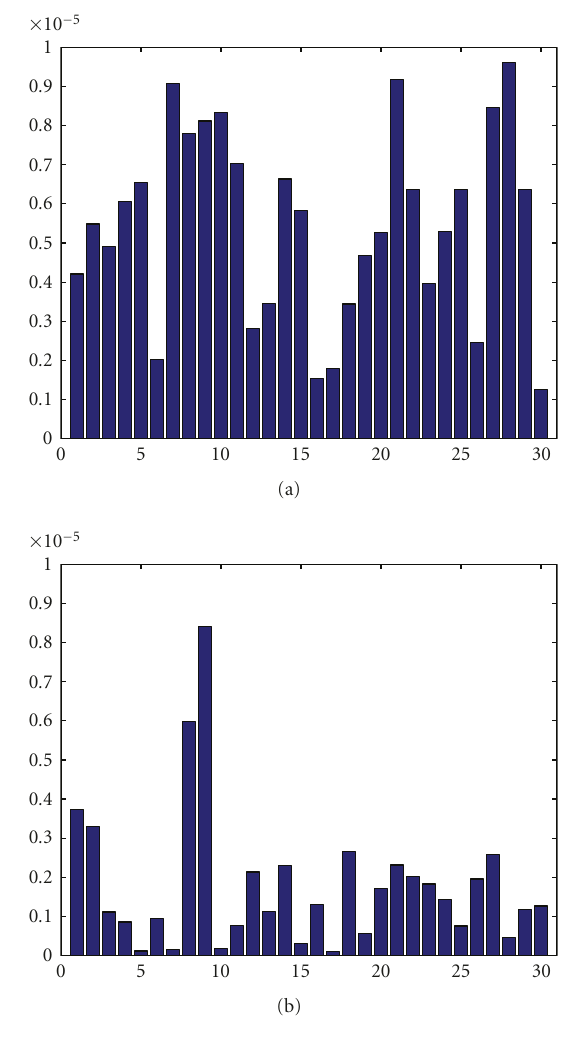
Figure 10: Joint power control, multiuser detection, and routing: distribution of powers versus node number, (a) initially, (b) after convergence (final distribution of